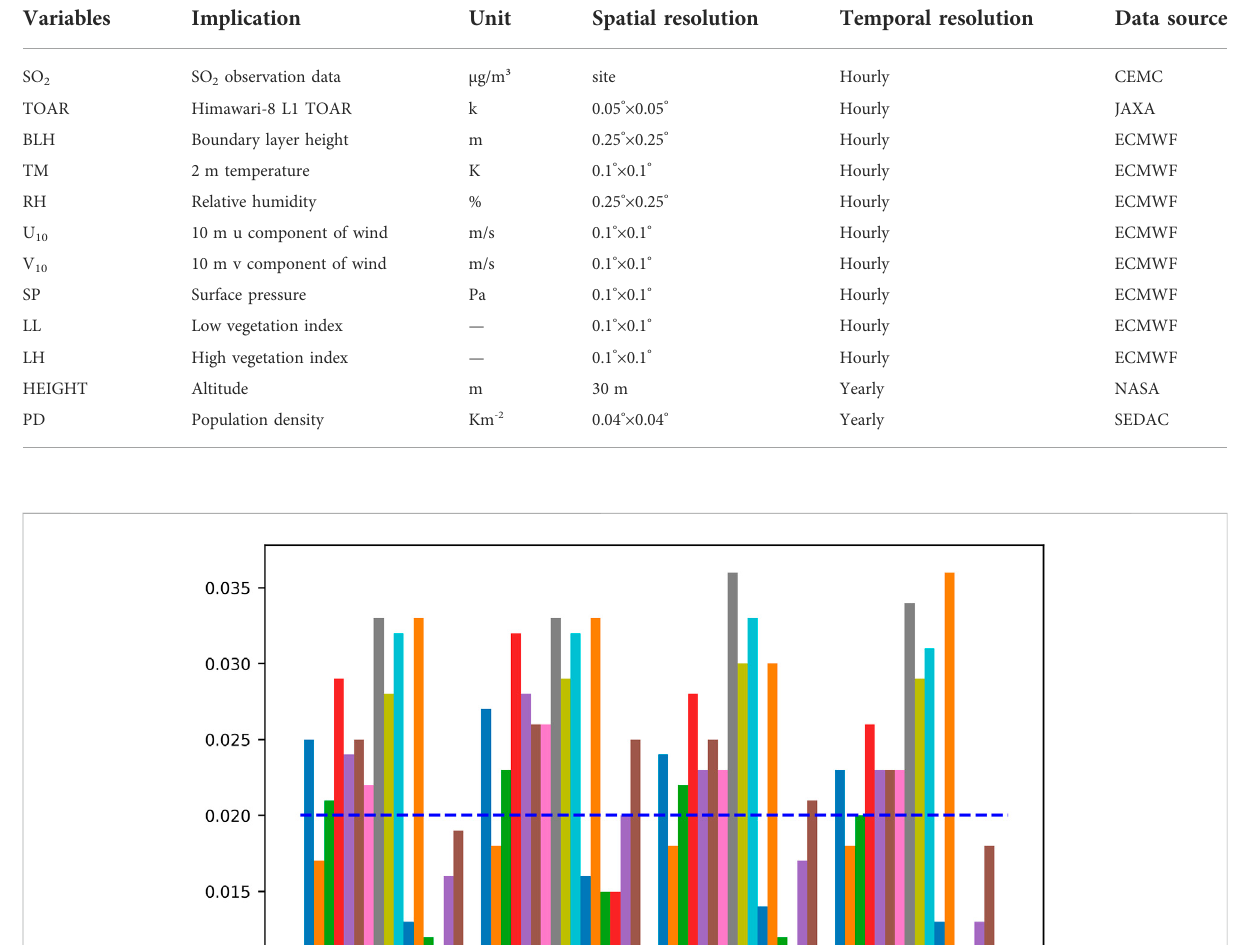
TABLE 2 Details of the data used in the study.